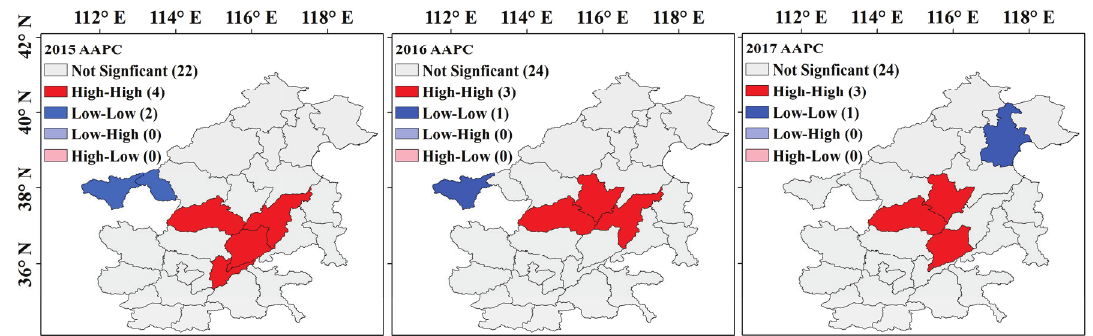
Figure 9. Local indicators of spatial association maps of city-scale AAPC for 2015, 2016, and 2017.